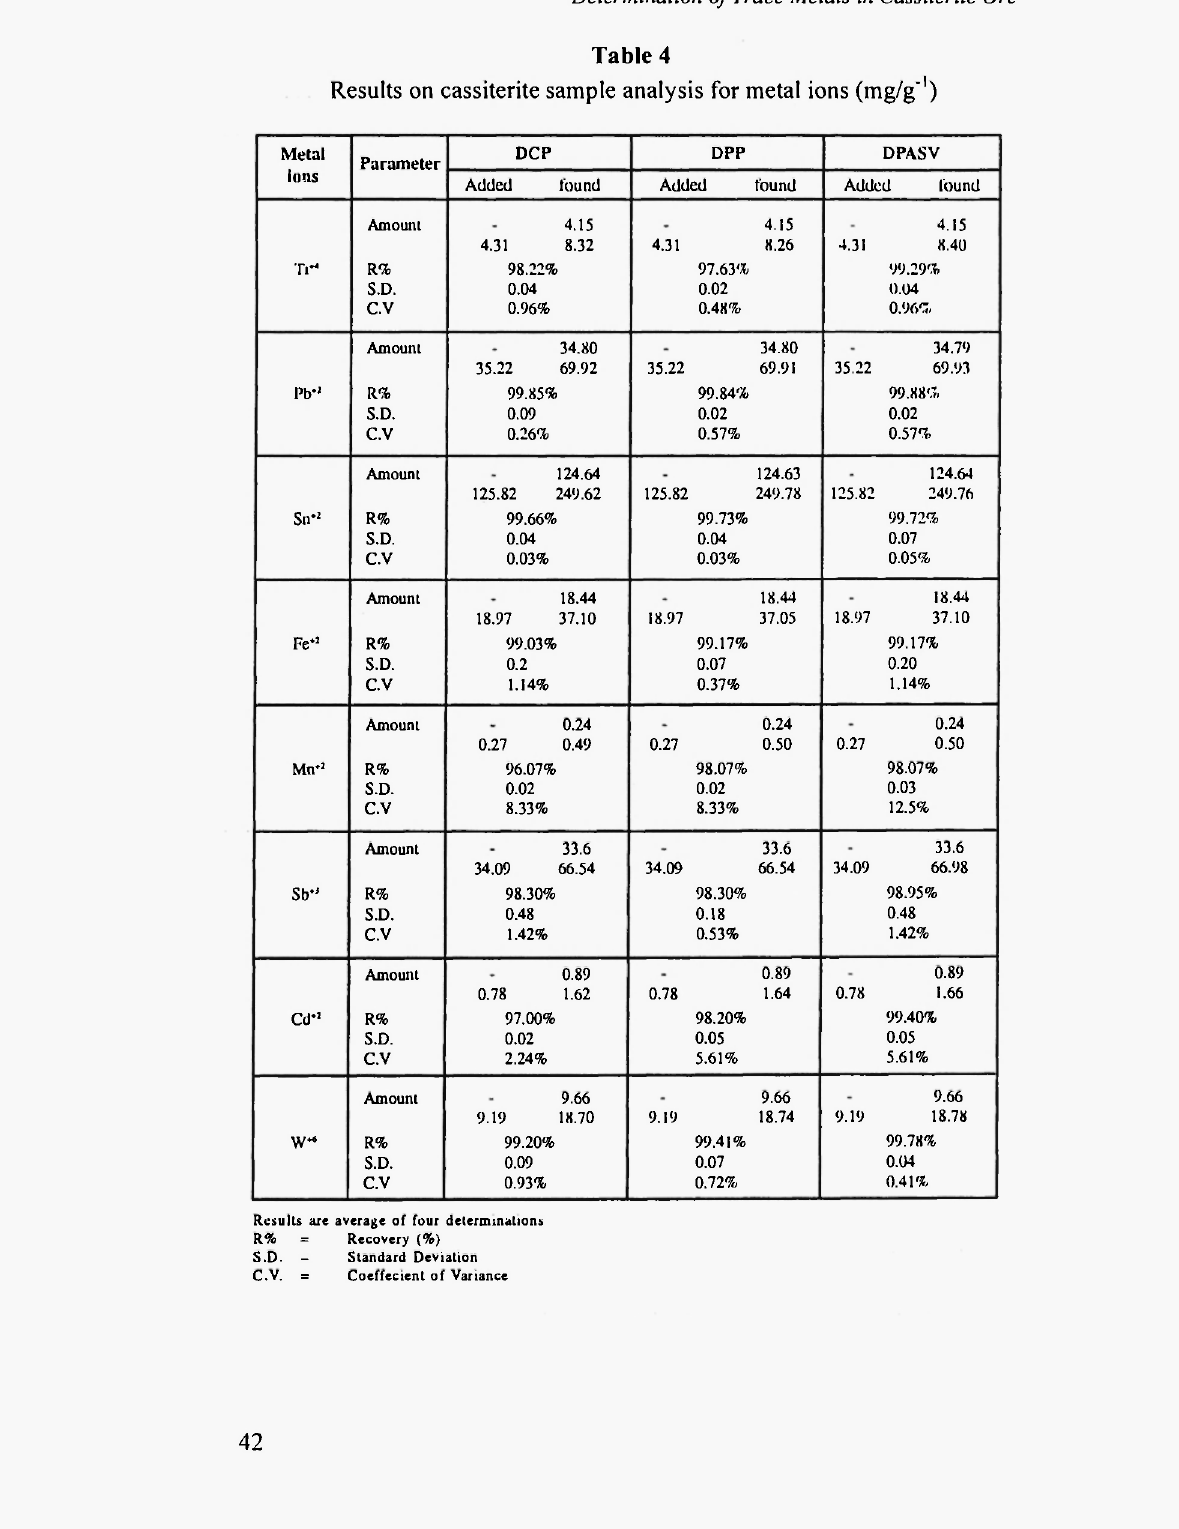
Results on cassiterite sample analysis for metal ions